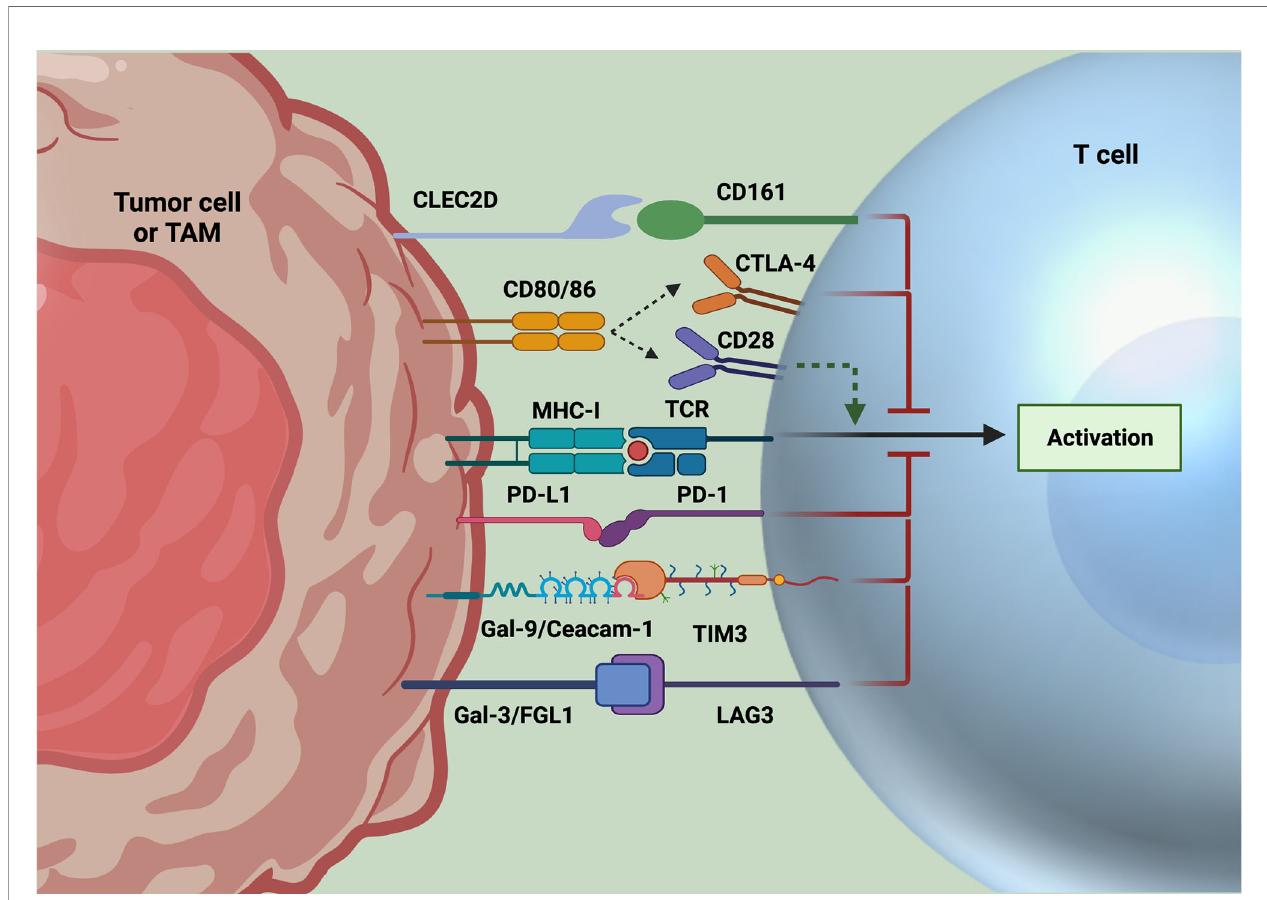
FIGURE 1 | Immune checkpoint inhibition strategies. Classically targeted immune checkpoints include PD1 and CTLA4. However, resistance to these checkpoints alone have led to the discovery of novel targets, including CD161, TIM3, and LAG3, whose ligands are expressed on tumor cells and often TAMs. After binding to their respective ligands, signaling of these immune checkpoints leads to suppression of T cell activation and effector function. Accordingly, these axes have been targeted for ICI, with promising results of increased T cell functionality to date. Created with